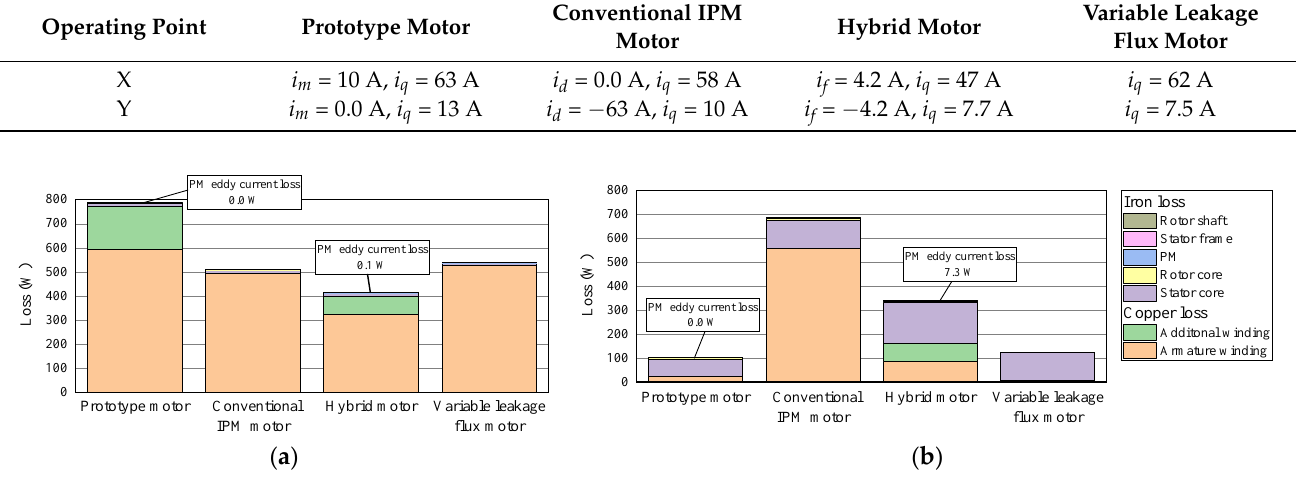
Figure 26. Loss analysis results: ( a ) loss at operating point X; ( b ) loss at operating point Y.